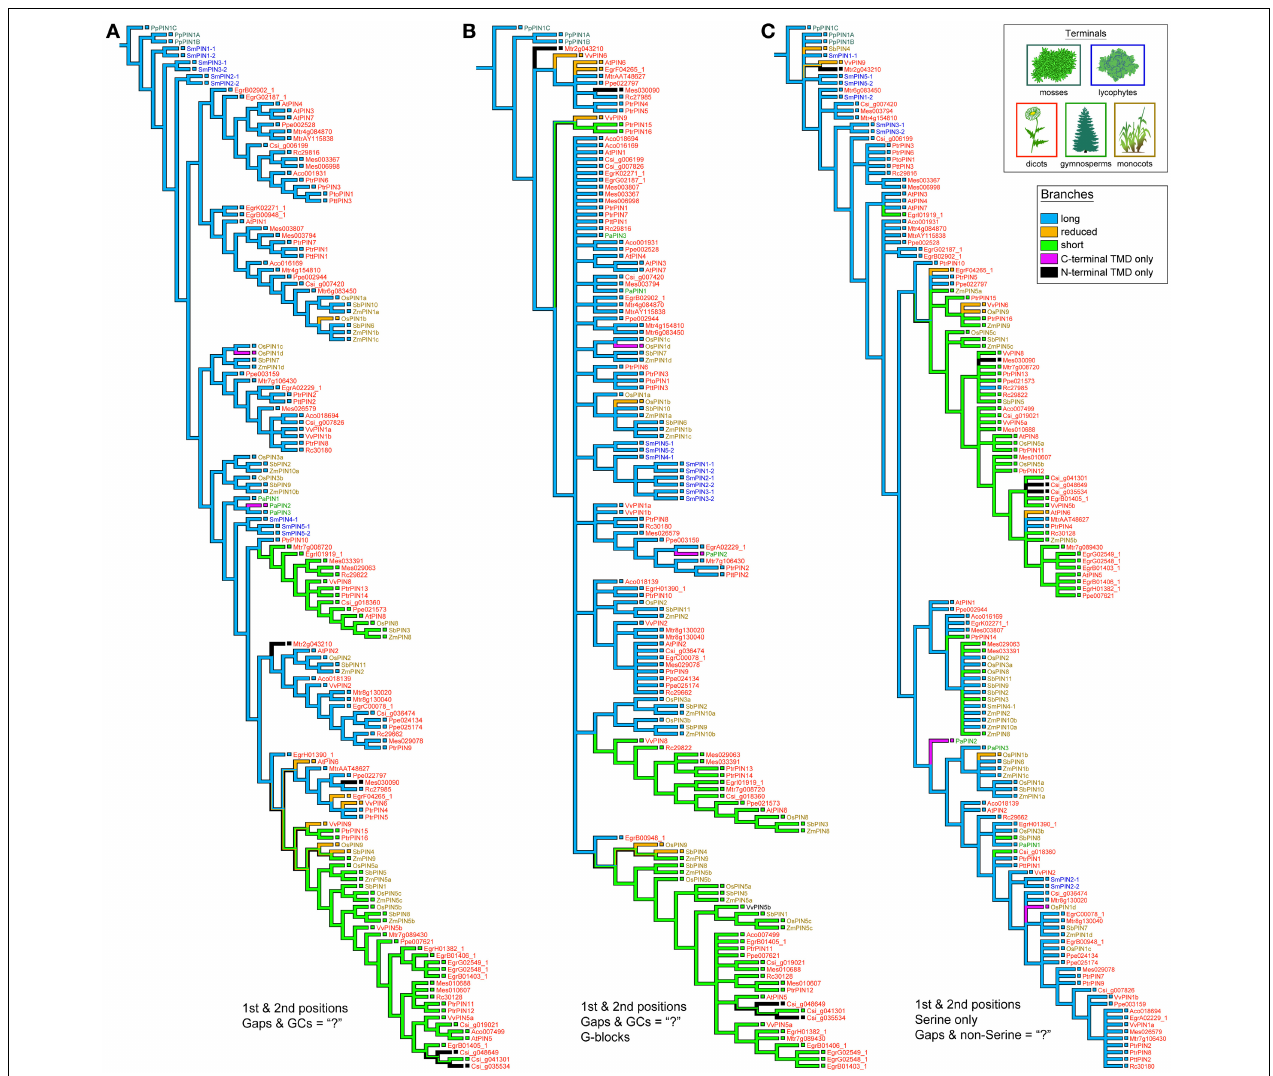
FIGURE 5 | Strict consensuses of equally parsimonious trees using various alignments of the PIN gene data set with only 1st and 2nd codon positions. With Gs and Cs removed, the influence of gaps was minimized so as to mimic how gaps and Ns are treated in likelihood programs by replacing